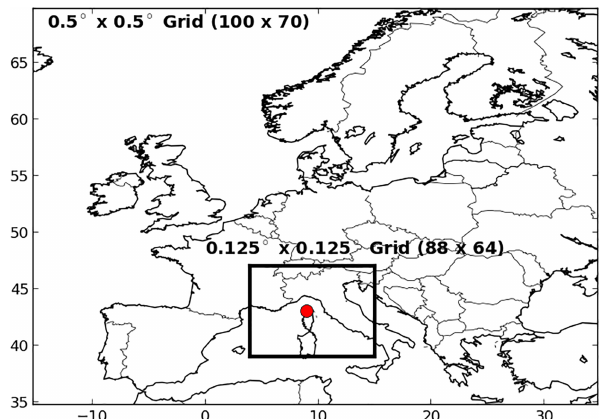
Figure 1. The nested modelling domains: the nesting domain over Europe and a nested domain over the northwestern Mediterranean, as delimited by a black rectangular contour in the figure. The red point indicates the Ersa station in Corsica